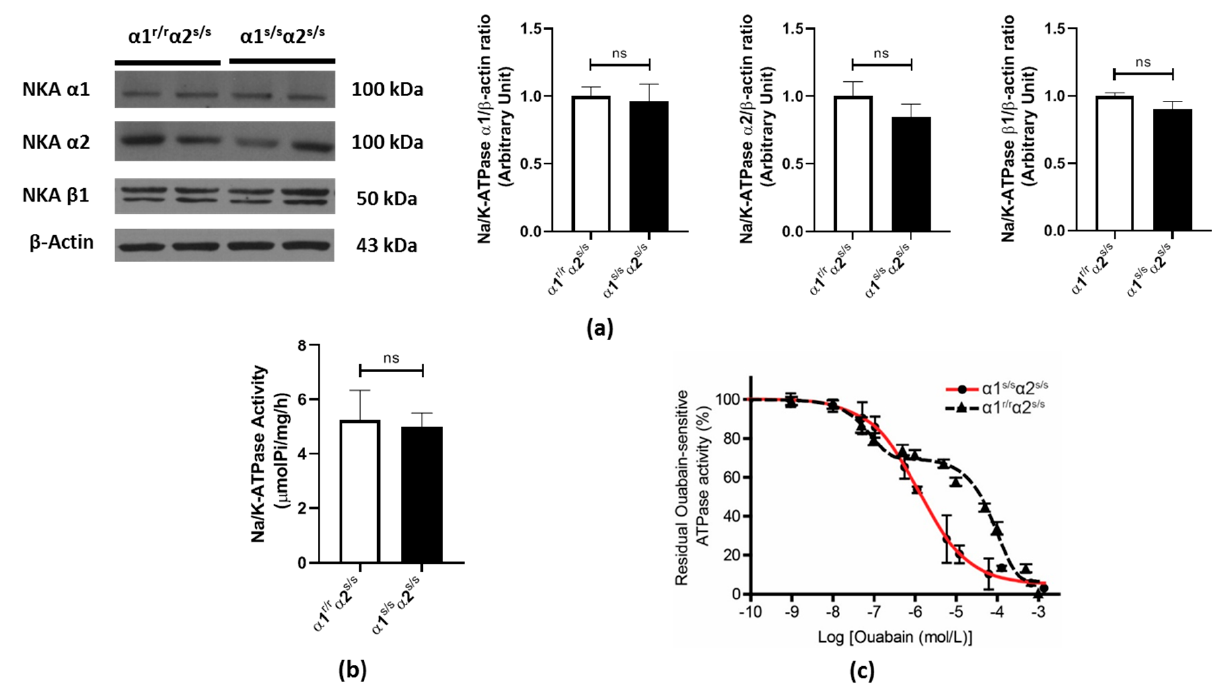
Figure 1. Increased Na/K-ATPase sensitivity to ouabain in α 1 s/s α 2 s/s hearts: ( a ) Representative Western blots and quanti- tative analysis for Na/K-ATPase α 1, α 2, and β 1 isoforms in heart homogenates ( n = 5–6 hearts/genotype). ( b ) Maximal ATPase activity in crude membrane fractions was measured using a colorimetric assay for Pi release ( n = 6 hearts/genotype). ( c ) Na/K-ATPase dose–response curve to the cardiotonic steroids (CTS) ouabain. Maximal ATPase activity in crude mem- brane fractions was measured using a colorimetric assay for Pi release in the presence of the ionophore alamethicin and the indicated concentrations of ouabain. The monophasic curve obtained for the α 1 s/s α 2 s/s is shown in red along with the biphasic curve obtained in the wild-type ( α 1 r/r α 2 s/s ) mouse heart ( n = 3 hearts/genotype). ns: non-significant, p > 0.05.